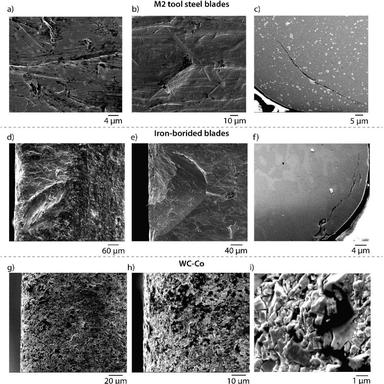
SEM images of worn blade tips. (a–c) M2 tool steel. (d–f) Iron borided. (g–i) WC-Co.